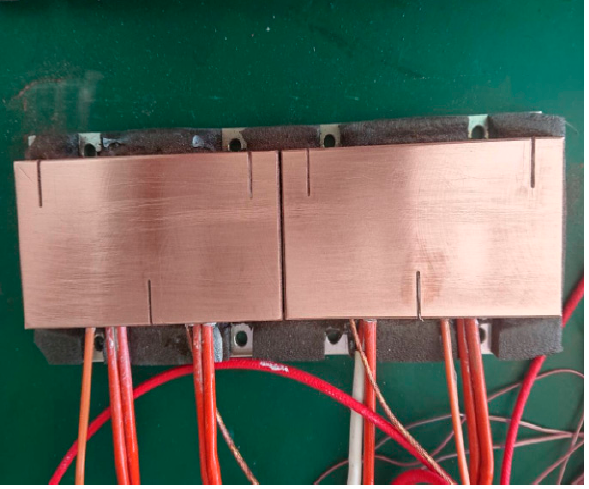
Figure 18. A heat generator (Dummy Heater).